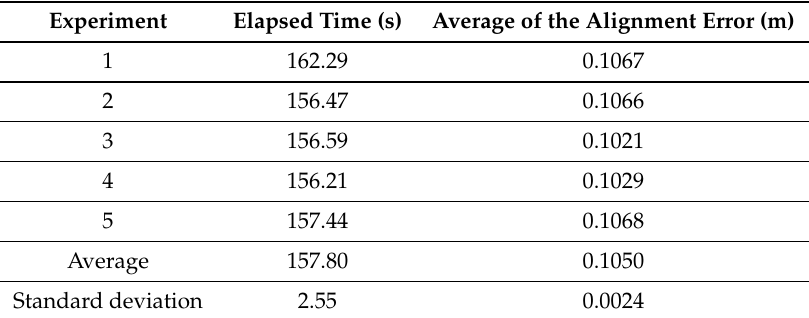
Table 8. Autonomous Mode Experiments.